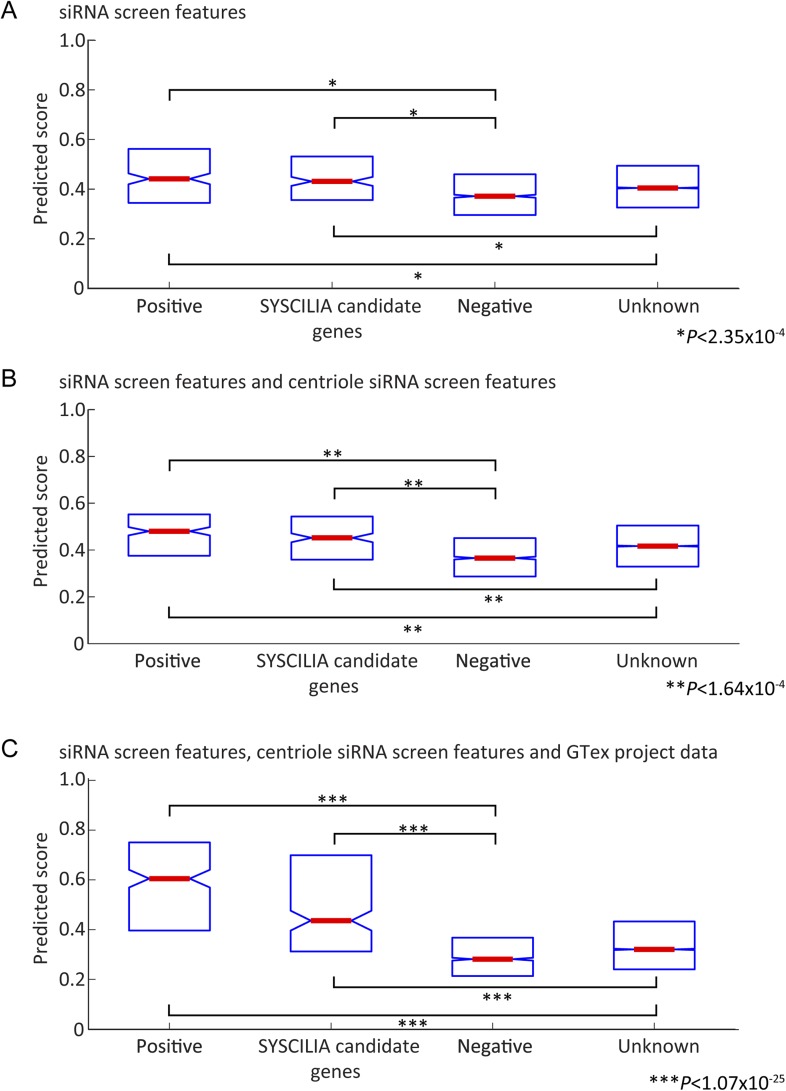
Prediction score on Gold standard and Gold standard candidates.(A–C) Box plot reporting median value (red center bar) and interquartile ranges (blue box) of the classifier scores for gold standard positive and negative genes (out of bag performance, that is, for every gene the score excludes trees where the gene was used for training), also included are boxes for a set of ciliopathy candidate genes (SYSCILIA candidate genes) and genes not annotated to be ciliopathy related (Unknown), which were not used in the training. (A) Classifier based on cilia siRNA screen features only. (B) Classifier based on cilia siRNA screen and centriole siRNA screen features only. (C) Classifier including all siRNA and GTex project expression signature based features. In all cases, the median value for positive set or candidate genes differed significantly from the negative set or unknown set of genes (One-tailed Wilcoxon rank sum test).